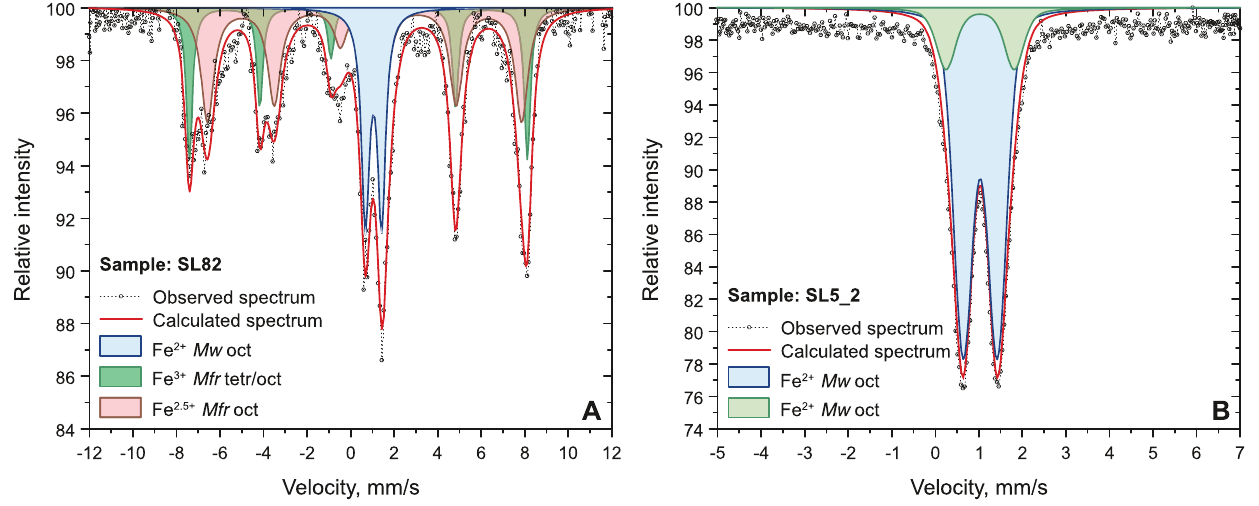
Fig. 2 | Mössbauer spectra of inclusions SL82 (A) and SL5_2 (B). A Blue doublet corresponds to Fe 2+ in the octahedral site of magnesiowüstite. Green magnetic sextet corresponds to Fe 3+ in octahedral and tetrahedral sites of magnesioferrite,